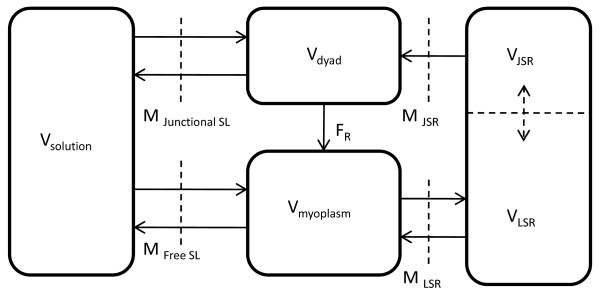
Fluid compartment model. Figure 3: Representative fluid compartment model, showing membrane surface area separating different compartments. MFreeSL: free SL membrane; MJunctionalSL: junctional SL membrane; MjSR: junctional SR membrane; MLSR: Longitudinal SR membrane.